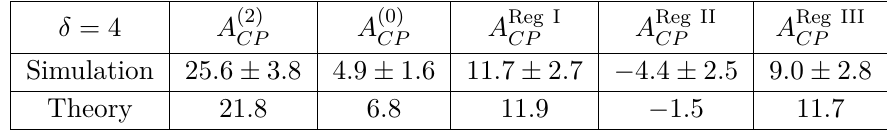
Table 2 . The simulated values and uncertainties of various observables (in %), for δ = 4 . The theoretical values are also presented for comparison.